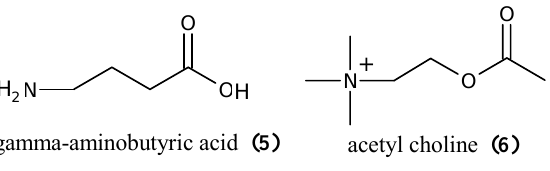
Figure 2 : COX enzyme assay – conversion of arachidonic acid to prostaglandin F (adapted from [28]) PGH synthase (COX) 2 OCOOH O